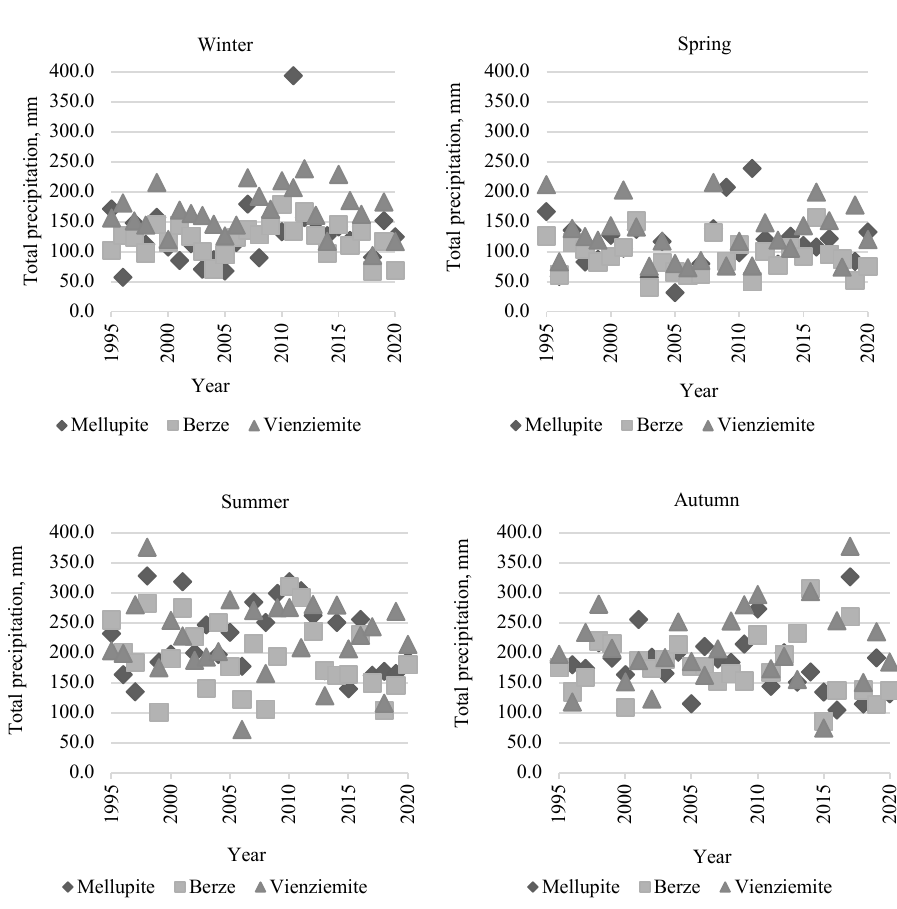
Fig. 2. Seasonal total precipitation (mm) in agricultural monitoring sites Berze, Mellupite, Vienziemite, time period 1995– 2020. The long-term seasonal changes in precipitation patterns is shown in Fig. 2. During the winter, four main precipitation types are observed: rain, freezing rain, sleet, and snow. Study of Iwata et al . concludes that a frozen soil layer generally increases the amount of surface runoff by decreasing soil permeability, slow flow transport pathways and lowered biotic activity and thereby delaying infiltration [16].